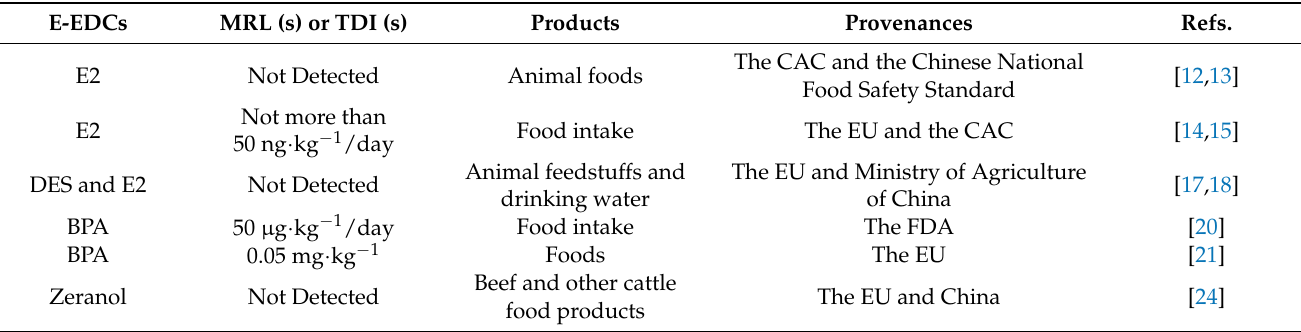
Table 1. Maximum Residue Limits (MRLs) and Daily Tolerable Intakes (TDIs) for some e-EDCs. Products Provenances Refs. The CAC and the Chinese National Animal foods Food Safety Standard